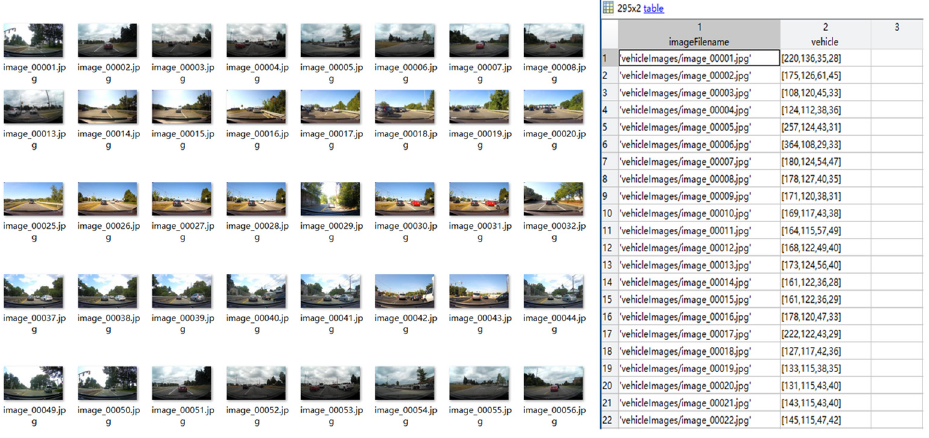
Figure 6. Custom data set in this